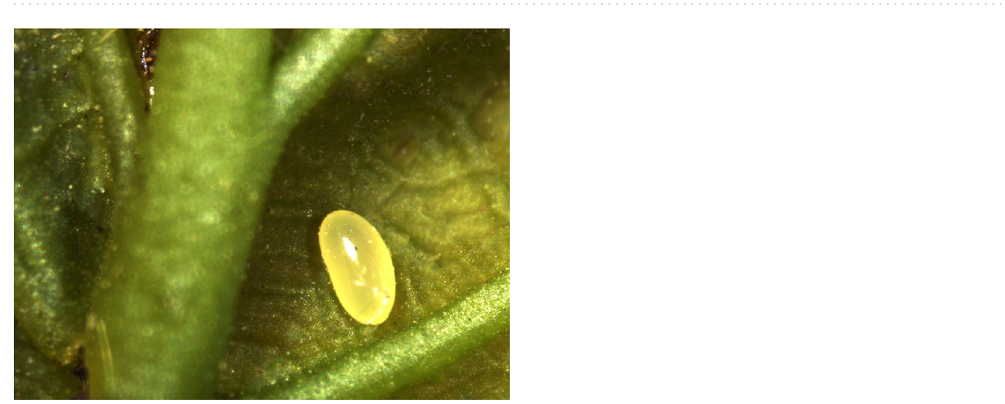
Figure 4. Dynamics of active overwintering adult (spring adult) occurrence of Rhynchaenus maculosus in different locations.